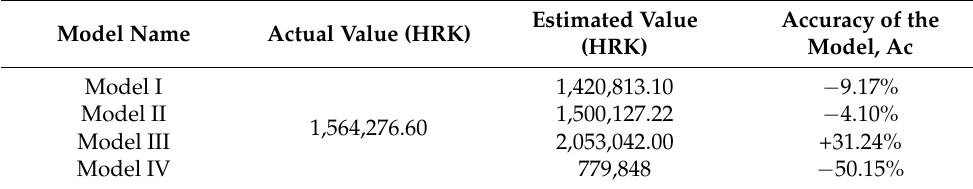
Table 14. Validation results of four models on the test